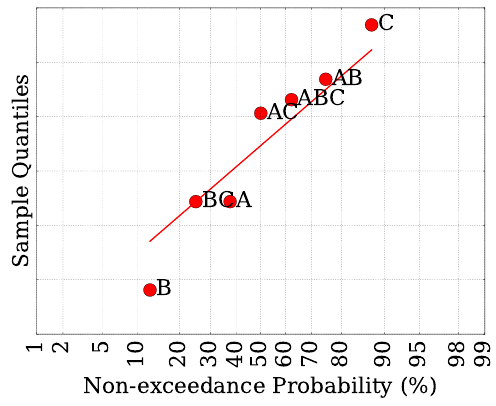
Figure 15: Abrasion resistance